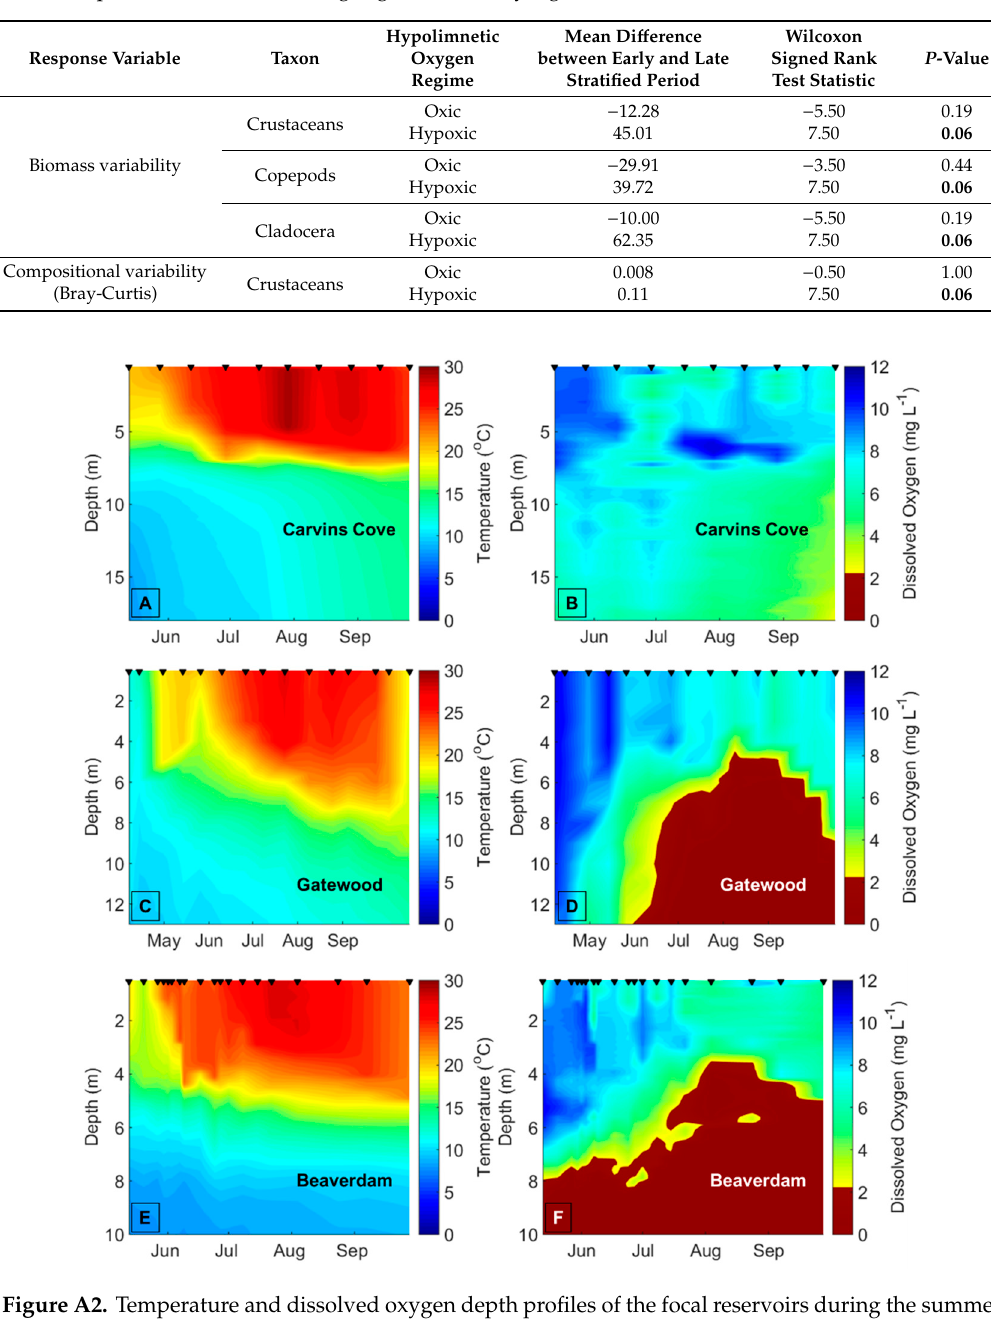
Table A3. Wilcoxon signed rank test statistics of the di ff erence in crustacean zooplankton, cladoceran and copepod biomass variability, and the compositional variability of crustacean zooplankton biomass between the early (when all reservoirs were oxic) and late stratified periods across years in oxic and hypoxic reservoirs, when the breakpoint between early and late stratified period was 1 week earlier than shown in Table 5. Only the compositional variability of total crustacean zooplankton (not individual copepod or cladoceran group taxa) was calculated, because there were only two copepod taxa present in the reservoirs. A positive mean di ff erence shows that the value increased from the early to late stratified period. Bold P -values highlight statistically significant ( P < 0.10) two-tailed P -values.